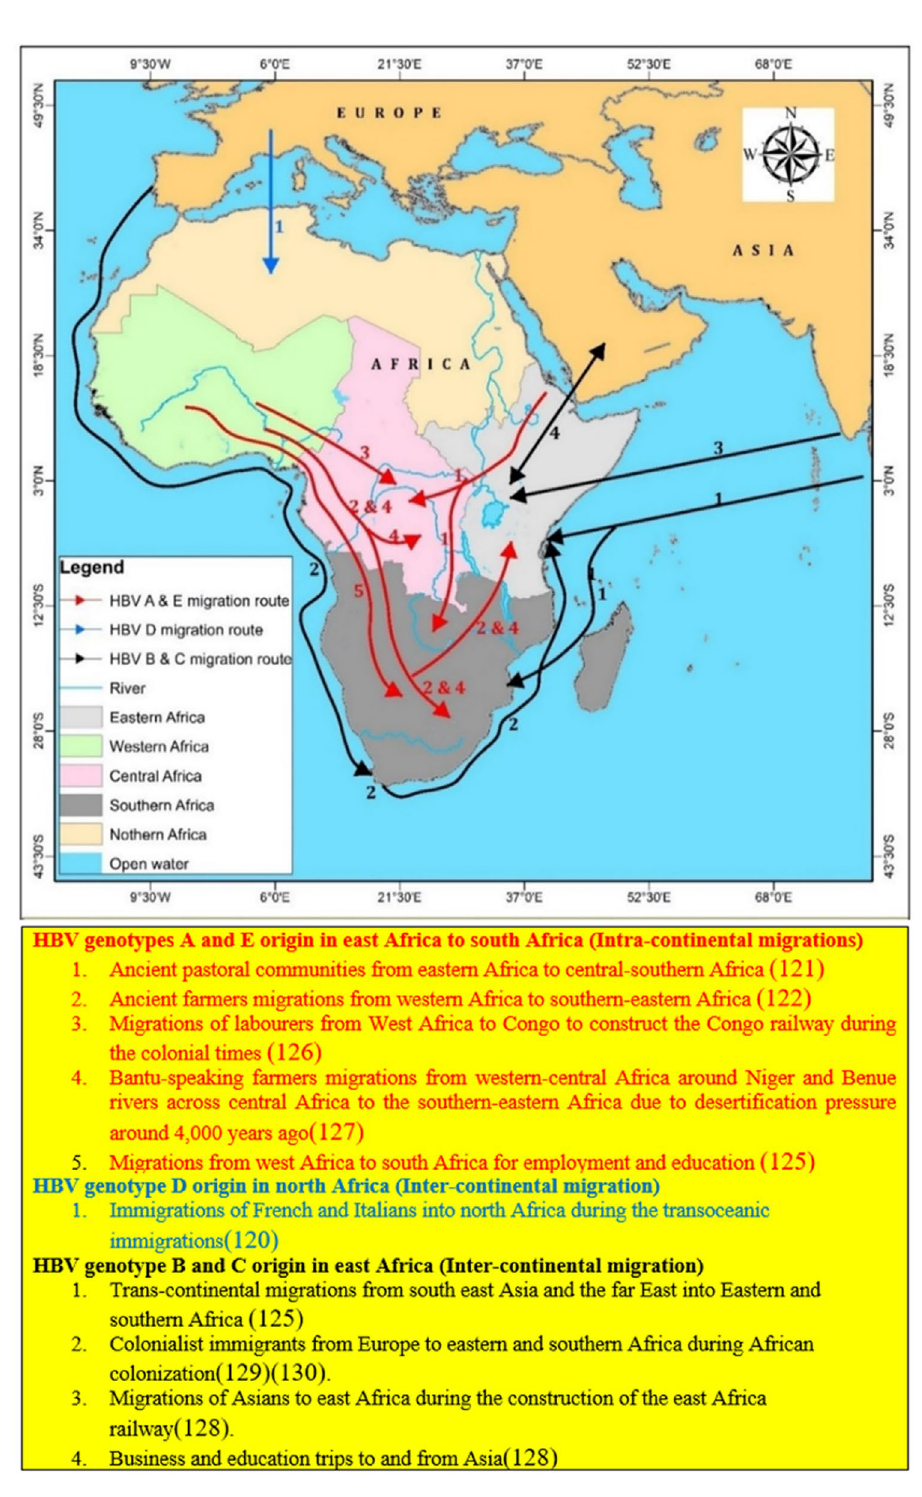
Figure 1. Intra and intercontinental migrations to show the plausible origin of the genotypes in Africa: Map was generated by using ArcMap 10.7.1 software (https:// deskt op. arcgis. com/ en/ arcmap/ 10.7/ get- start ed/ setup/ arcgis- deskt op- quick- start- guide.